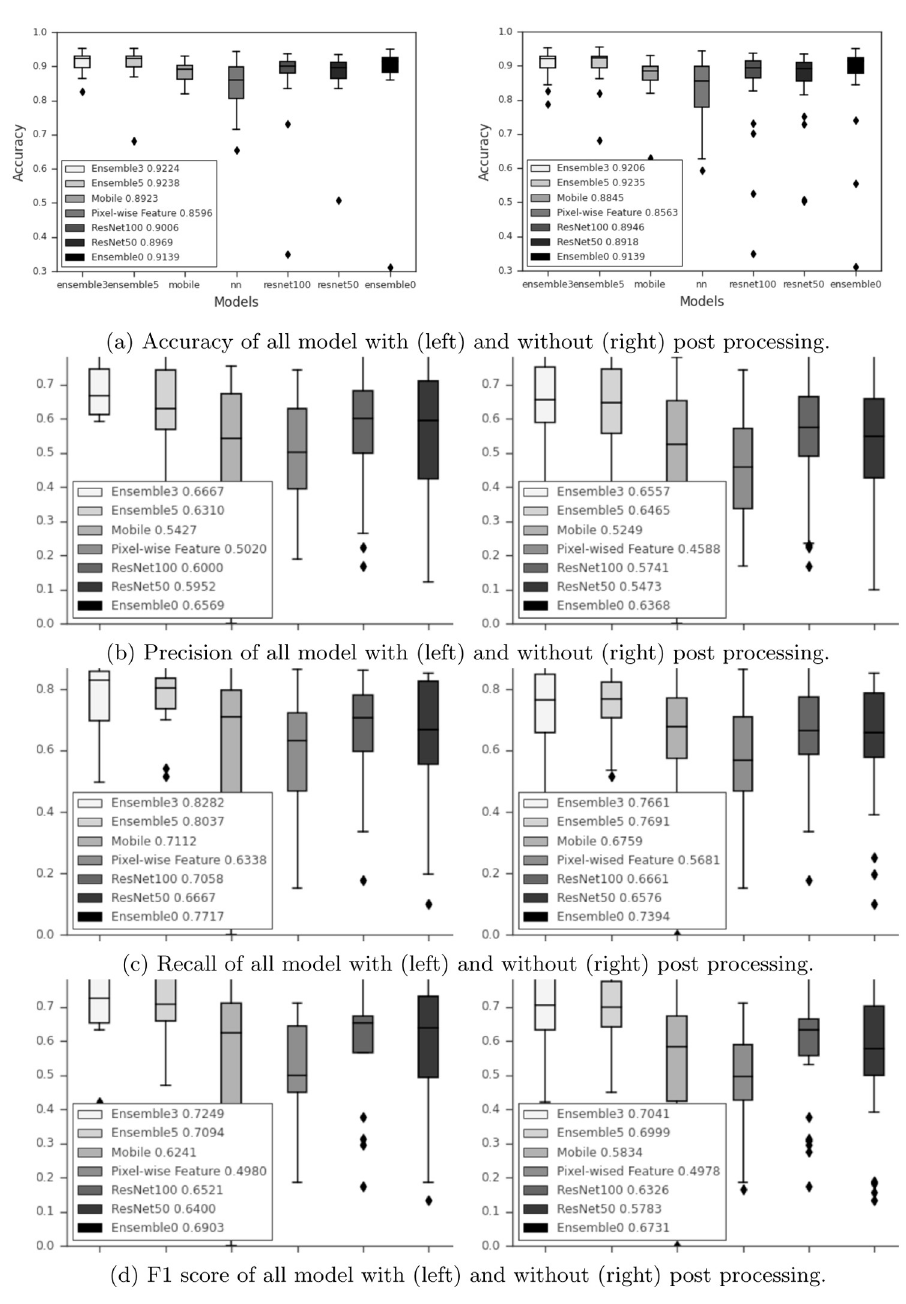
Fig 10. Accuracy (a), precision (b), recall (c), and F1 score (d) of Ensemble model with 3- and 5- blocks by MobileNet, ResNet101, and Resnet50. (a) Accuracy of all model with (left) and without (right) post processing. (b) Precision of all model with (left) and without (right) post processing. (c) Recall of all model with (left) and without (right) post processing. (d) F1 score of all model with (left) and without (right) post